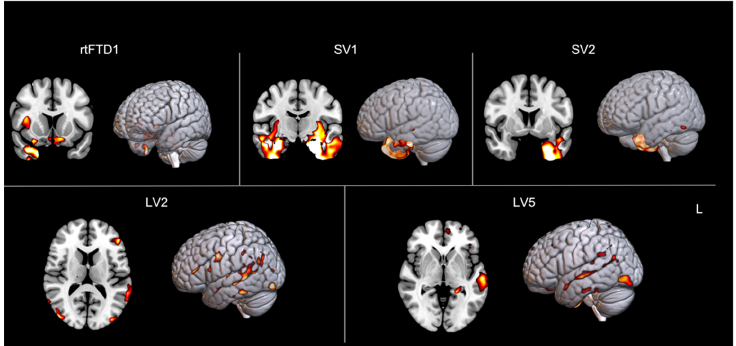
Figure 1. Results of whole brain voxel-based morphometry analysis showing atrophy patterns for each participant relative to controls ( n = 30, FWE < 0.05, k = 100, total intracranial volume and age included as covariates). Note that scans were available for only five participants. rtFTD = right temporal variant of frontotemporal dementia; SV = semantic variant; LV = logopenic variant.